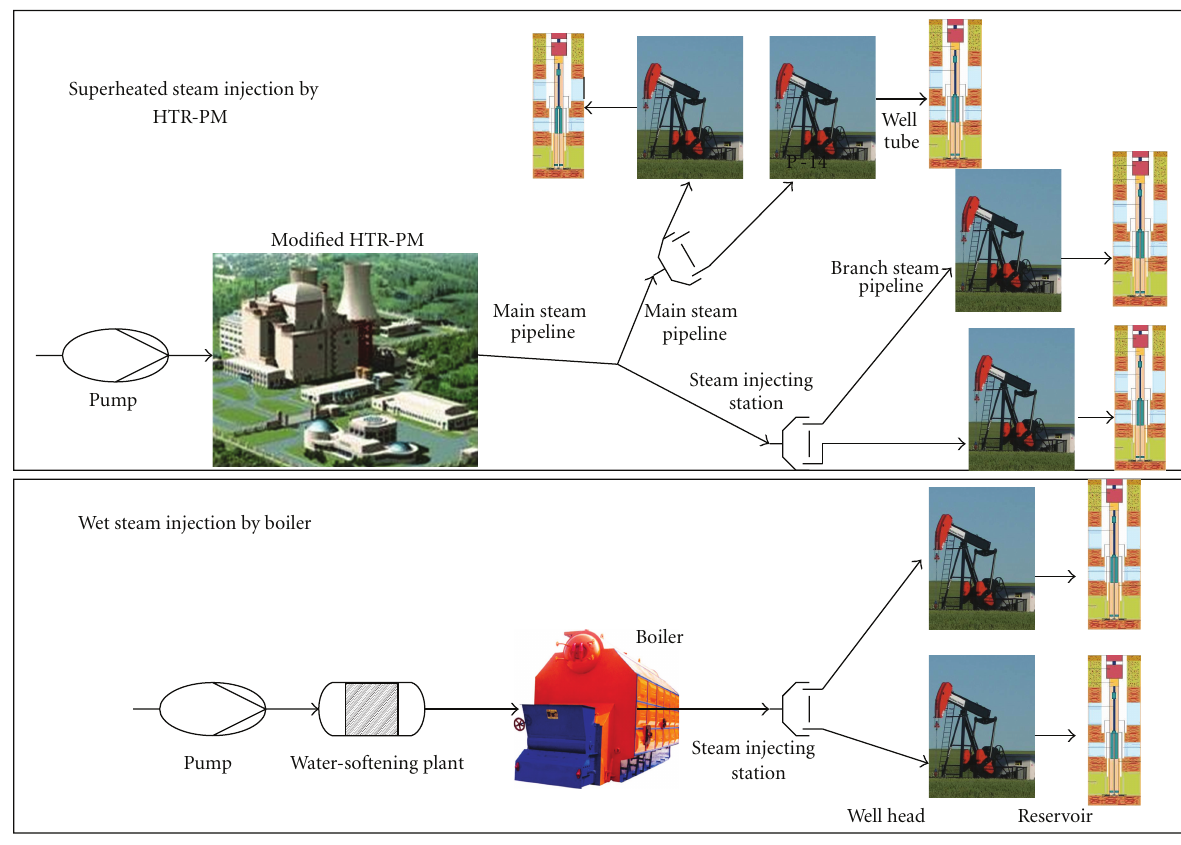
Figure 3: Strategies for steam injection by HTR-PM and